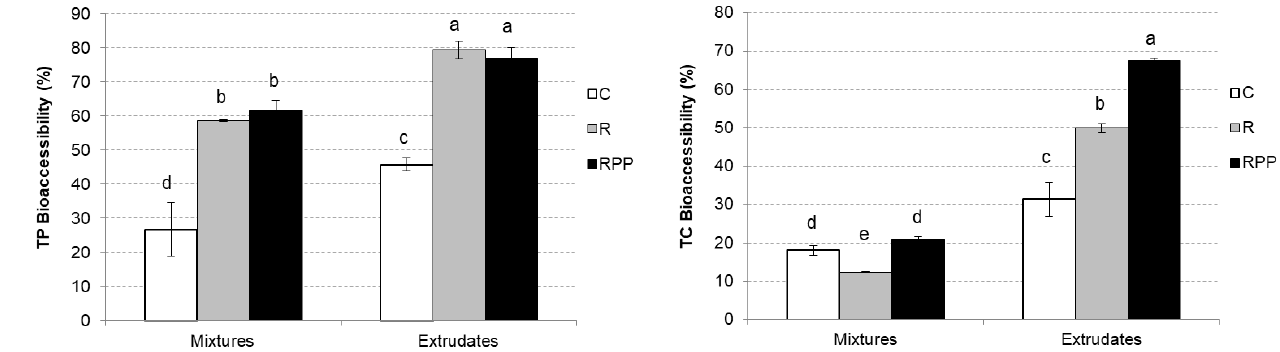
Figure 2. Mean values and standard deviation of ascorbic acid (AA), vitamin C (VC), and total folate’s (TF) bioaccessibility. Letters indicate homogeneous groups established using ANOVA ( p < 0.05). Mean values and standard deviation of TP and TC mixtures’ and extrudates’ bioacces- sibility is displayed in Figure 3. TP extrudates emphasized significant differences ( p < 0.05) compared to mixtures, while the same trend was observed in TC extrudates. For example, TC mixtures’ bioaccessibility ranged in values of 11–21%, while extrudates’ values ranged from 31% to 68%.